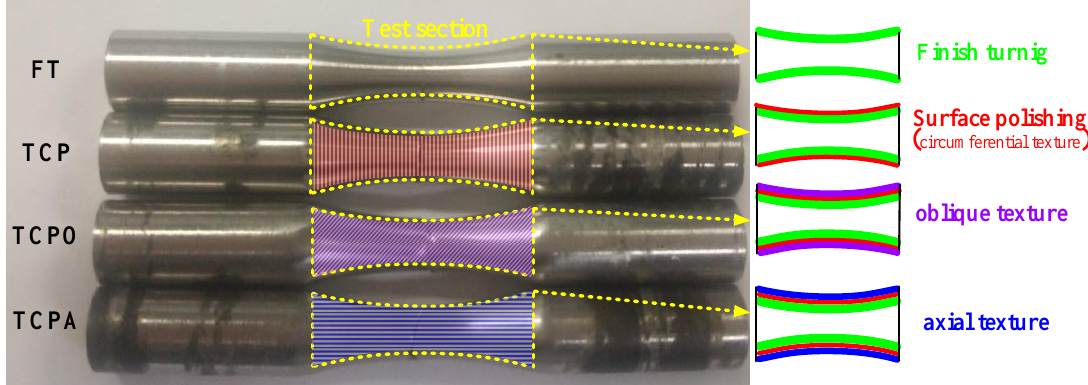
Figure 3. Specimen preparation for each series.